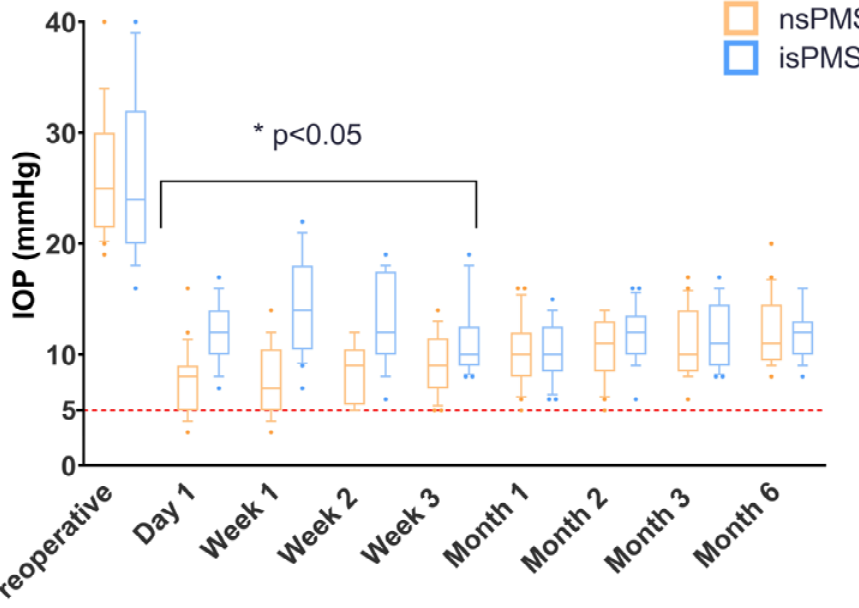
Figure 2. Box and whiskers plot showing the summary of postoperative intraocular pressure (IOP) measurements at each time point for each group. The height of the box represents the lower and upper interquartile range (50% of the range), and the ends of the whiskers extend to 80% of the range (10% to 90%). The line bisecting each box represents the median IOP. The horizontal red dashed line marks the lower IOP limit associated with hypotony (<6 mm Hg). The median IOP is also shown beneath the line. nsPMS: non-stented Preserflo MicroShunt implantation. isPMS: intraluminal stenting Preserflo MicroShunt implantation. IOP: intraocular